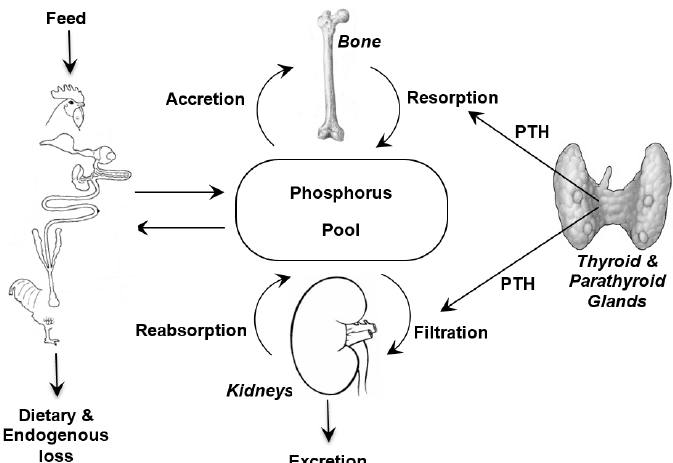
Figure 1. Phosphorus metabolism. Coordination of three organ systems, intestine, kidneys and bone, is central to Ca and P homeostasis. Reduced circulating concentrations of Ca causes increased secretion of parathyroid hormone (PTH) by the parathyroid glands. PTH increases bone resorption and renal Ca reabsorption but increased renal excretion of P. In the kidneys, PTH also stimulates formation of the hormonal form of vitamin D 3 which increases intestinal absorption of Ca and, to a lesser extent, the absorption of P. Elevated blood Ca concentrations as a result of these processes creates a negative feedback loop to ensure homeostasis. If hypercalcaemia occurs, calcitonin is secreted by the thyroid gland to inhibit bone resorption.